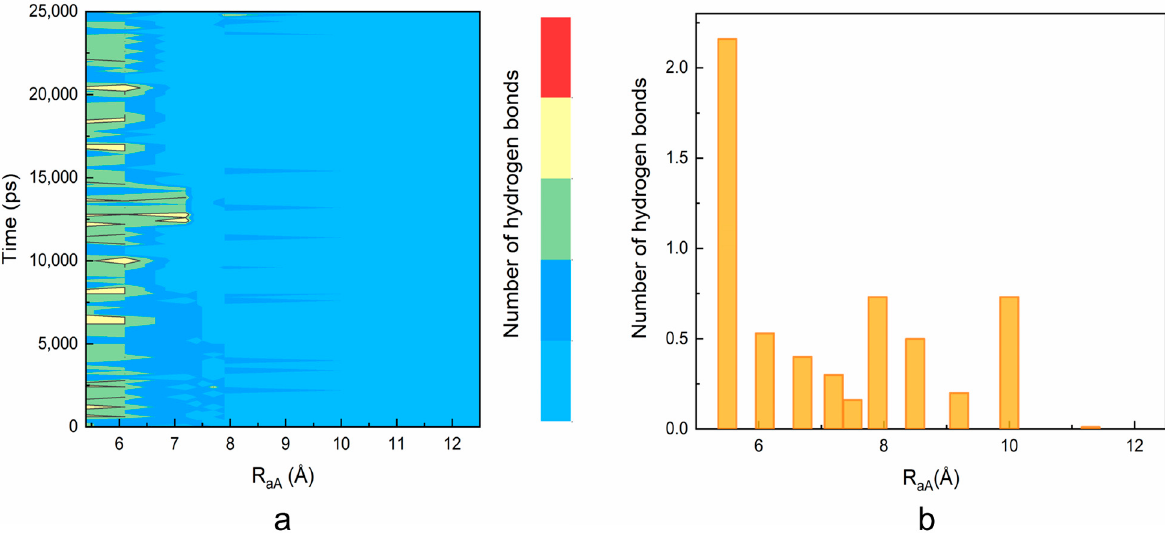
Figure 4. The evolution of the number of intermolecular hydrogen bonds in the TEGPy-ILPR G4 system along the ligand dissociation. ( a ) The number of intermolecular hydrogen bonds as a function of time and R aA . The number of hydrogen bonds (ranging from 0 to 4) is indicated using a color scale. ( b ) The average number of intermolecular hydrogen bonds against R aA . The number of hydrogen bonds is computed at each R aA value as an average over the 25 ns constrained MD simulations.